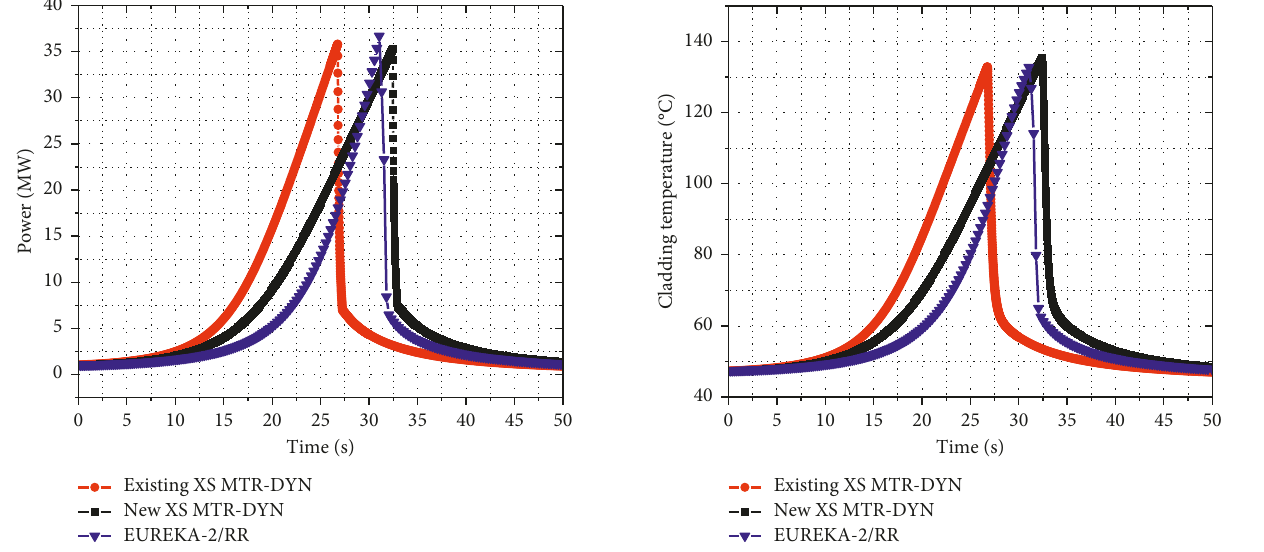
Figure 16: Cladding temperature during RIA transient at initial power of